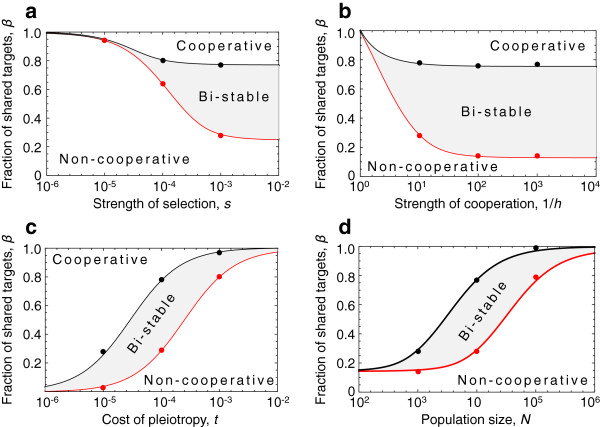
Evolutionary parameters that permit cooperative regulation. Evolutionary parameters that permit the evolution of gene regulation by cooperative transcription factors. Threshold number of shared targets for gain (black) and loss (red) of cooperative binding to be advantageous in a population at equilibrium under stabilising selection. The black line shows the value of βabove which a new mutation that results in cooperative binding will invade in a population that lacks cooperative binding. The red line shows the value of βbelow which a mutation resulting in loss of cooperative binding will invade, in a population that has cooperative binding. For values of βthat lie in the gray region, the dynamics are bistable: a population with cooperative binding will preserve it, and one without binding will not gain binding. The threshold fraction of shared targets varies with (top left) strength of selection, s, (top right) strength of cooperativity in reducing the effects of deleterious mutations 1/h, (bottom left) the cost of pleiotropy t and (bottom right) the population size, N. Lines show our analytic equations (Equations 2 and 3), and points show the results of 105replicate Monte-Carlo simulations. Parameter values (unless stated otherwise) are ul=2×10−7, ug=10−7, K1 + K2=100, s=10−3, h=10−1, t=10−4and N=104.